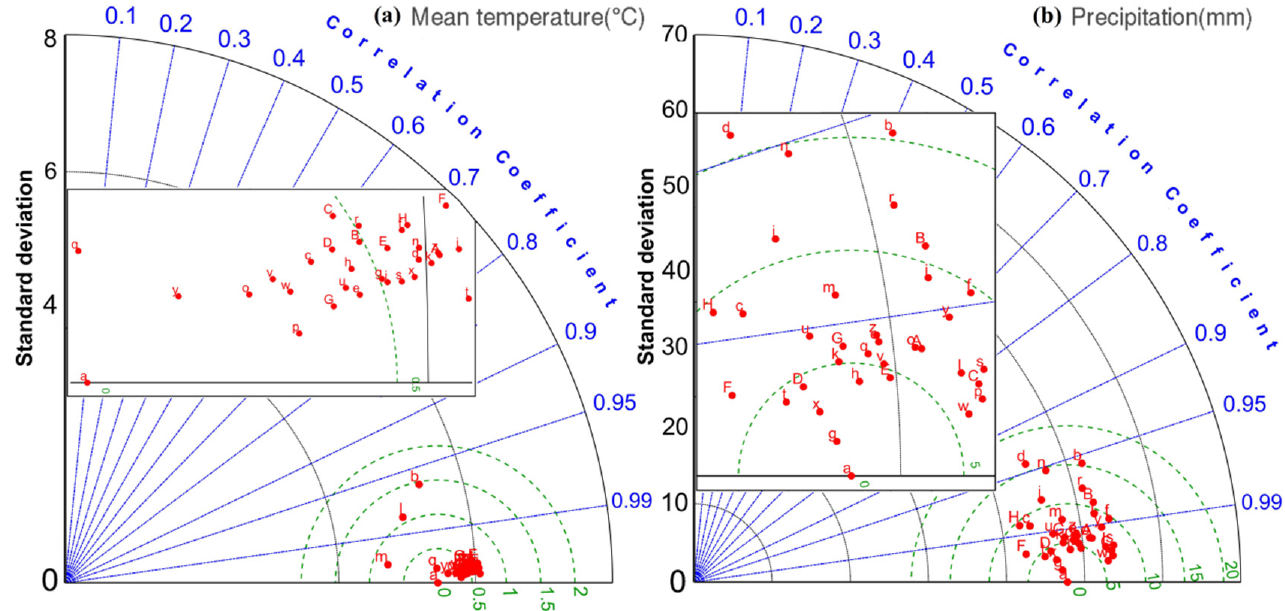
Figure 5. Taylor diagrams for temperature and precipitation of midwestern Jilin region between the observations and simulation results for 1980–2020.